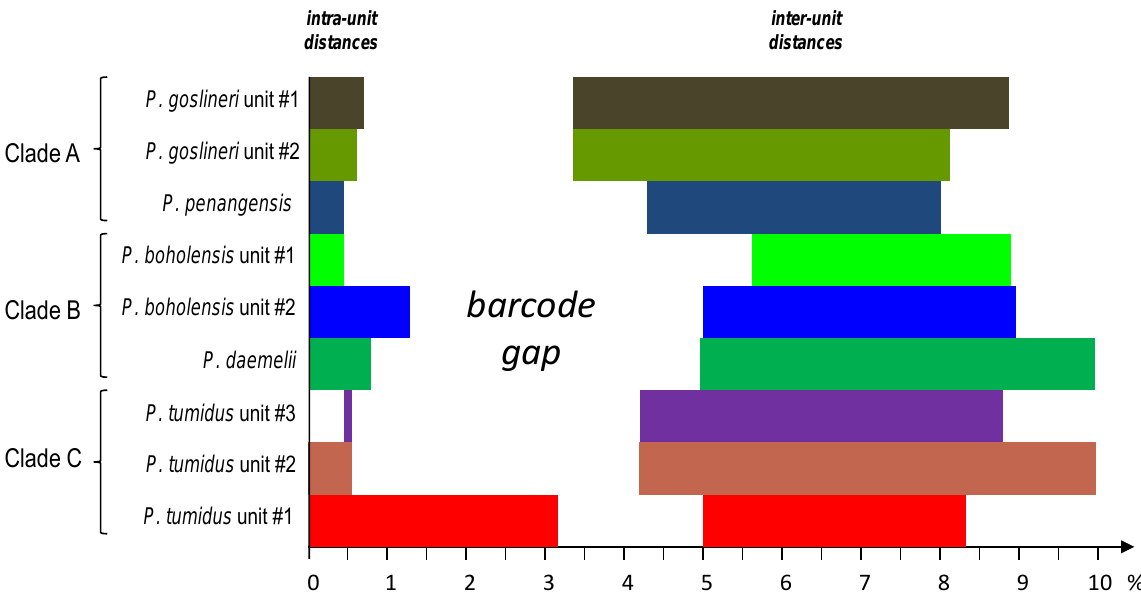
Fig. 5. Diagram that helps to visualize the data on pairwise genetic distances between COI sequences within and between mitochondrial units in Paromoionchis gen. nov. (see Table 3). Ranges of minimum to maximum distances are indicated (in percentages). For instance, within P. tumidus (Semper, 1880) unit #1, individual sequences are between 0 and 3.2% divergent; individual sequences between P. tumidus unit #1 and the other units are minimally 5% and maximally 8.4% divergent; overall, the distance gap between P. tumidus unit #1 and the eight other units is between 3.2 and 5%. The colors used for each unit are the same as those used in Figs 1–4 and